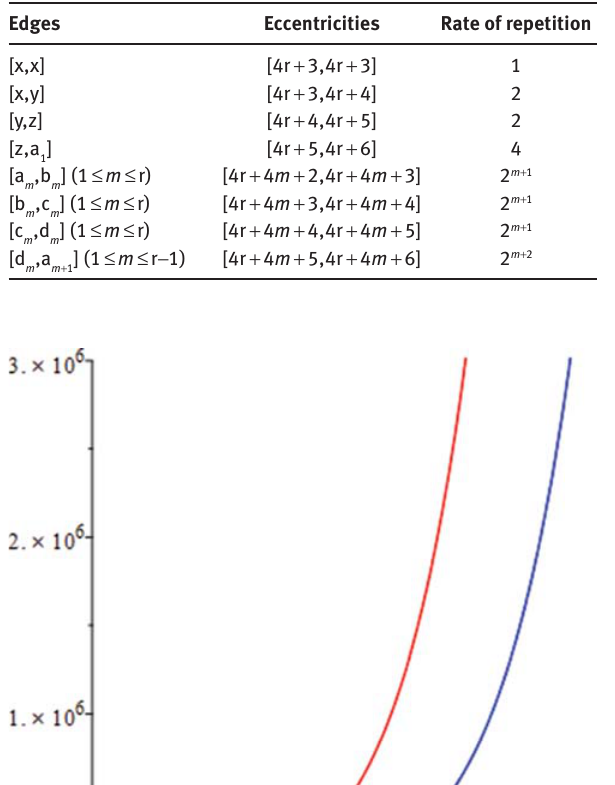
Table 4 : The edge distribution of PD [r] with reference to edges and their rate of occurrence. The eccentricities are picked up from Table 2.